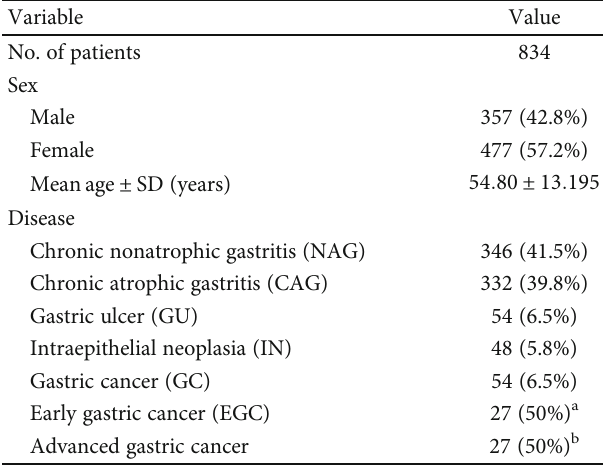
Table 1: Baseline data and disease